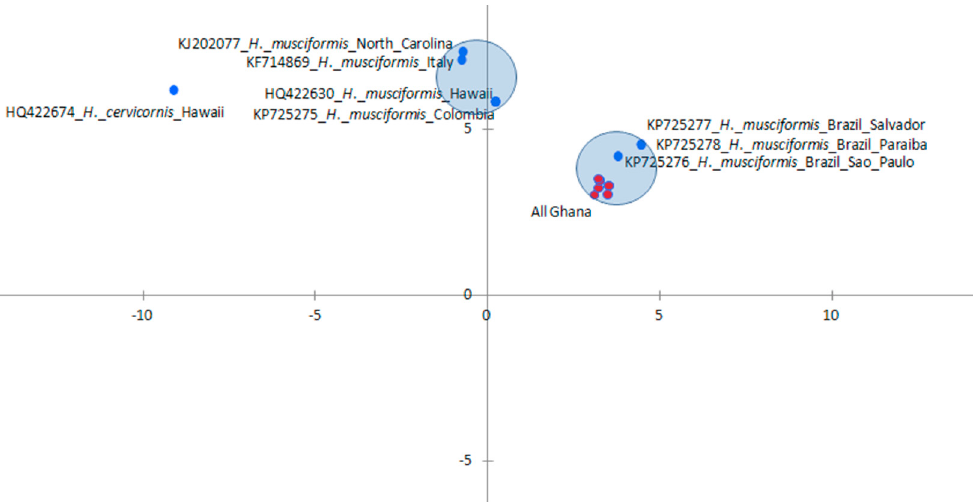
Figure 5. Multidimensional scaling analysis (XLSTAT, 2016) of the divergences of COI barcode sequences from Ghanaian H. musciformis associated to other H. musciformis sequences available in GenBank.